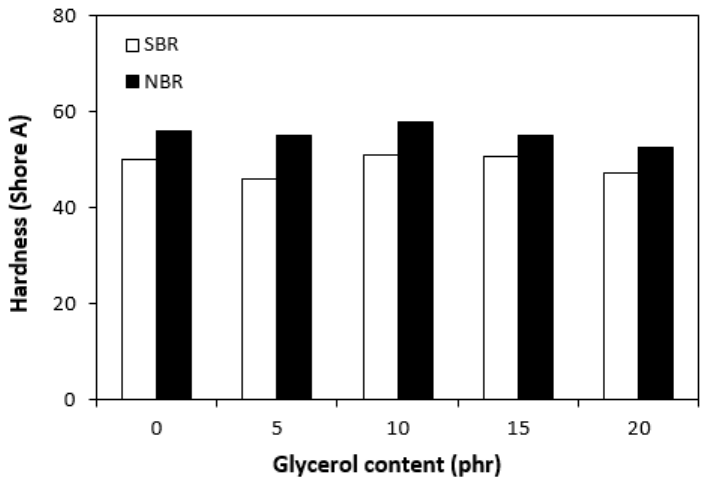
Figure 12. Influence of glycerol content on hardness of vulcanizates.